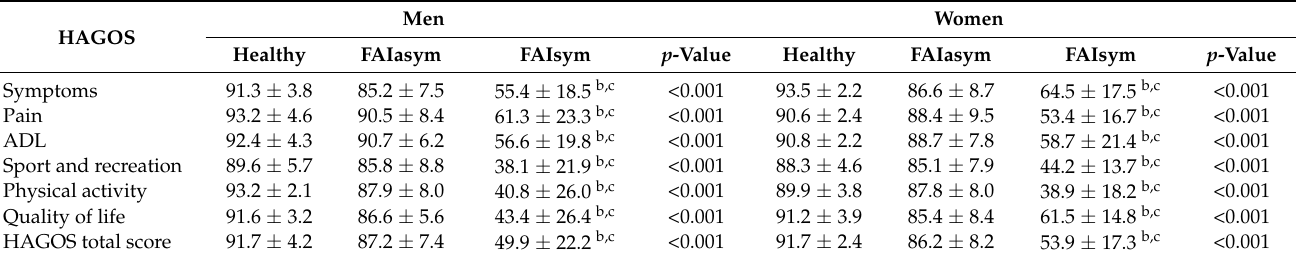
Table 2. Participant’s hip score using questionnaire.